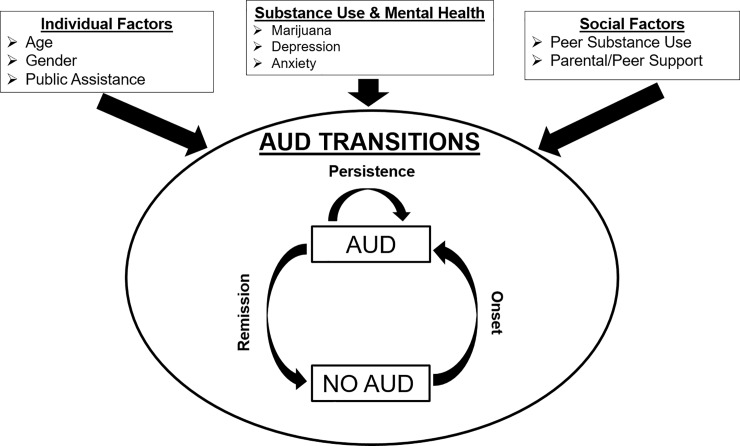
Conceptual model of AUD transitions.